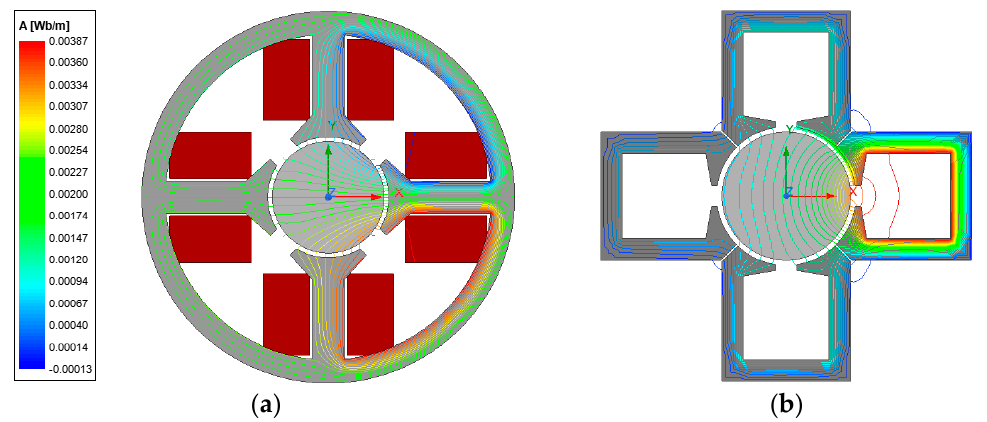
Figure 6. Magnetic force according to the control current of the existing model and the STMB.